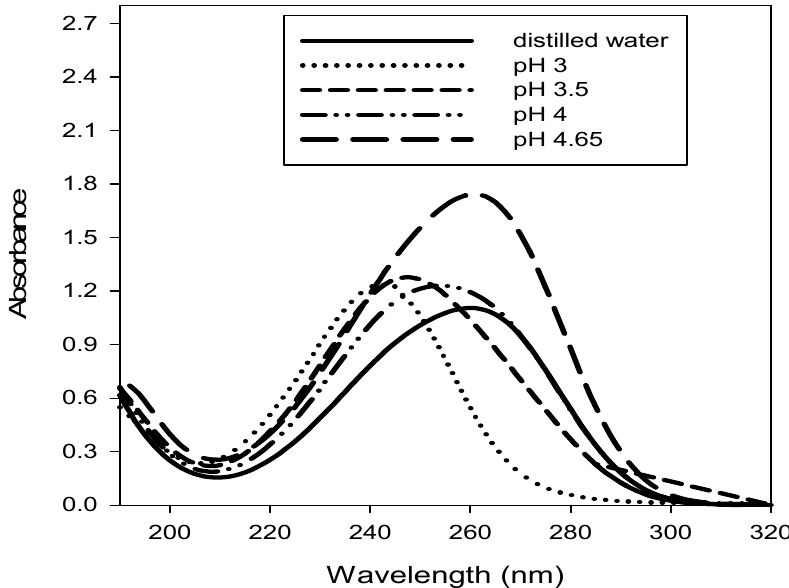
Figure 1. UV- visible spectra of 20 µ g mL − 1 ascorbic acid in distilled and mobile phase of different pH.